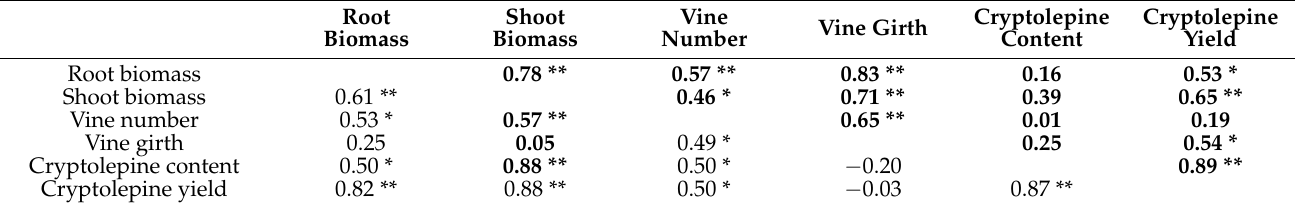
Table 4. Correlation between plant biomass, vine number, girth, cryptolepine content and yield in C. sanguinolenta . Root Vine Shoot Cryptolepine Cryptolepine Vine Girth Biomass Number Biomass Content Yield